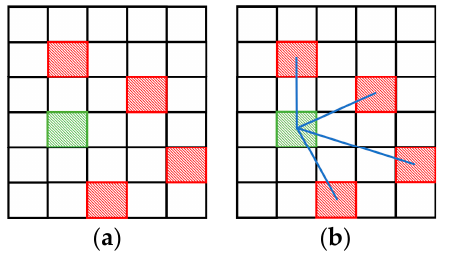
Figure 2. Greedy solution process. ( a ) The beginning iteration. ( b ) The next iteration.